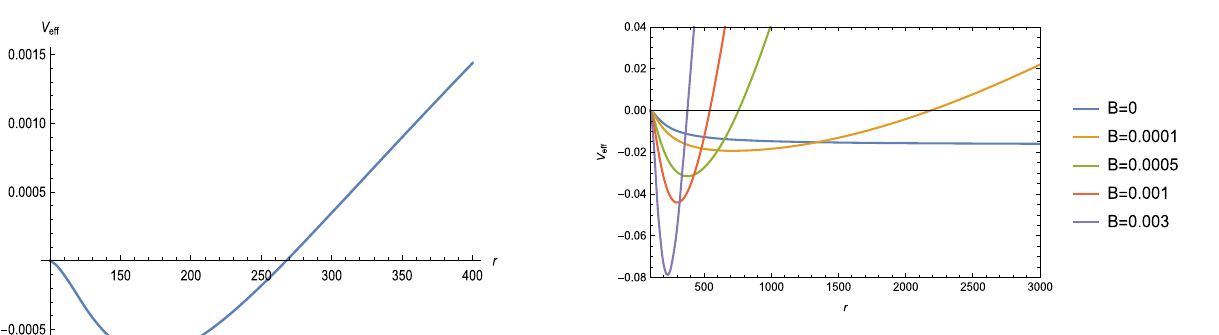
Fig. 3 Plot of V ef f ( r ) . The parameters are chosen as M = 100, a = 80, Q = 60, q = 0 . 1, L = 5, and m = 0 . 06. The horizon is located at r = 100. The regions of V ef f < 0 are permitted to release the test particle such that the particle could reach the horizon. It shows that, in the case of a weak magnetic field, the stronger the magnetic field is, the closer we have to release the particle from the event